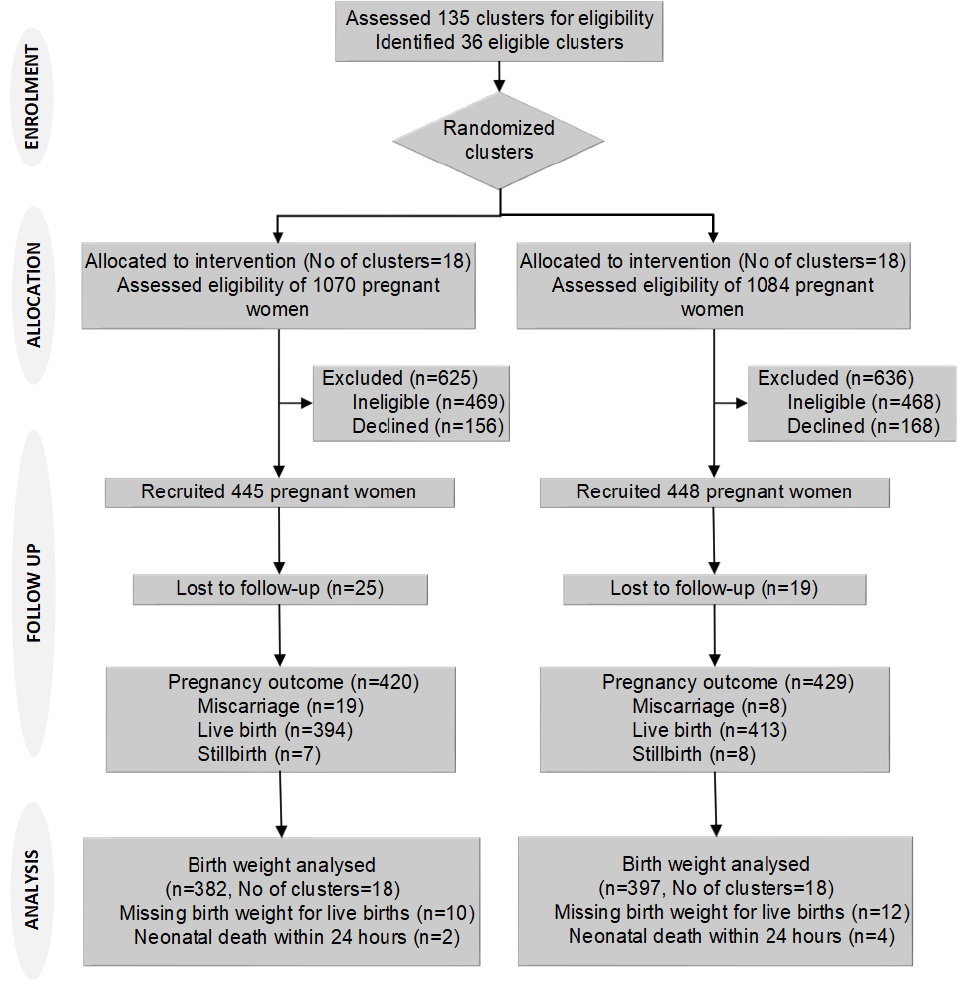
Figure 1. Trial flow chart. Table 1. Cluster, baseline maternal and household, and antenatal care and delivery characteristics by study